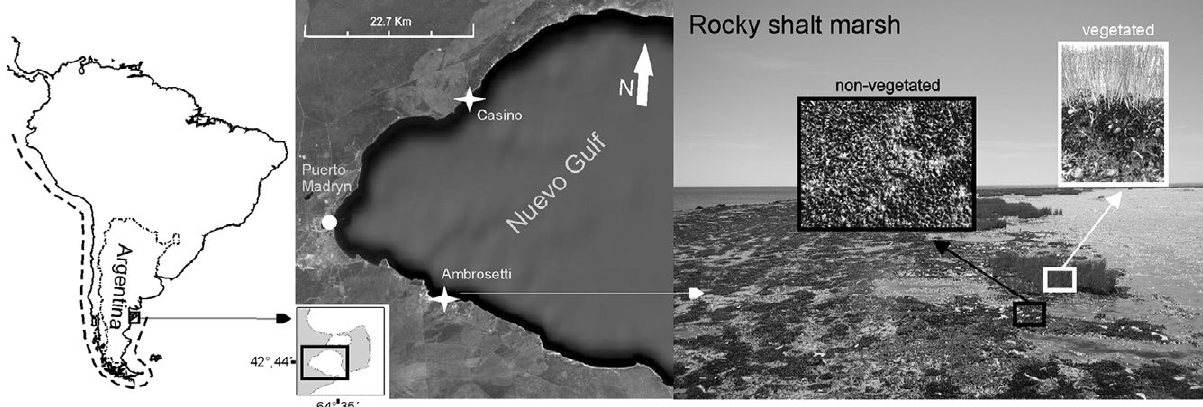
Fig. 1. – Map of the study area showing the distribution of the scorched mussel Perumytilus purpuratus (dashed line) and sampling sites (crosses). At the right, photographs showing a rocky salt-marsh and details of the sampled patches.